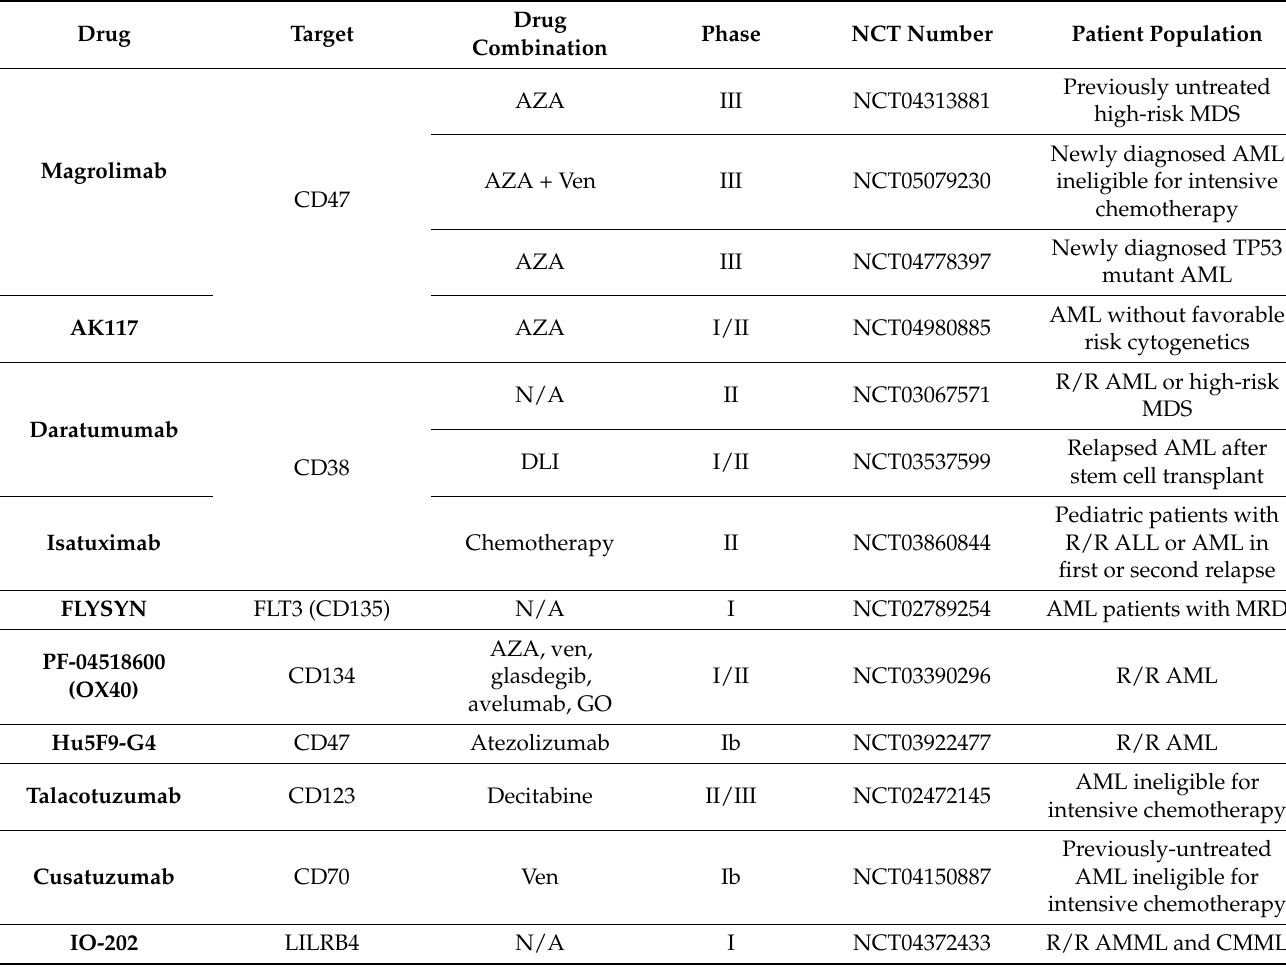
Table 1. Ongoing and recently completed clinical trials of unconjugated antibodies in AML or high-risk MDS. MEC, mitoxantrone, etoposide, and cytarabine. DLI, donor lymphocyte infusion. AZA, azacitidine. Ven, venetoclax. MRD, minimal residual